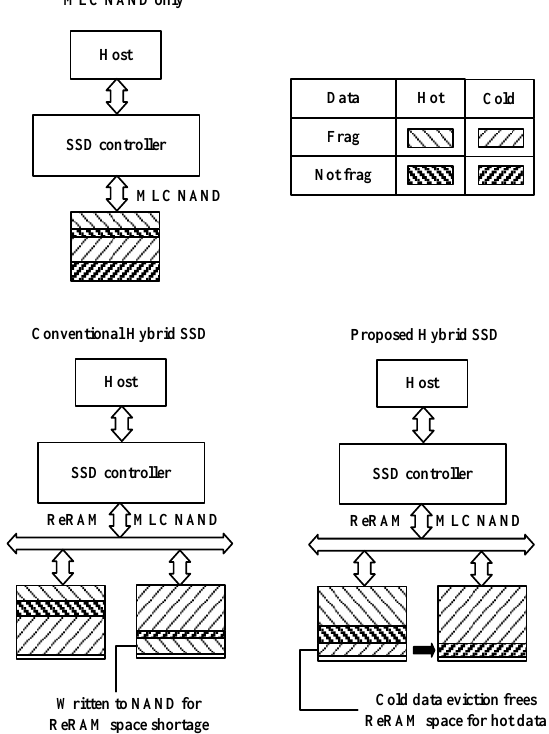
Fig. 6. The comparison of the proposed scheme with the existing